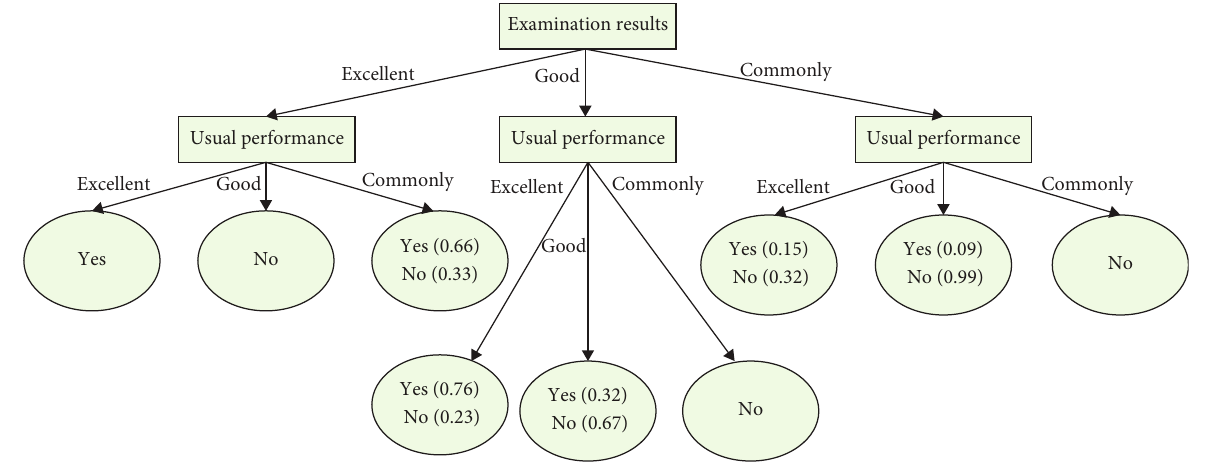
Figure 4: Decision tree